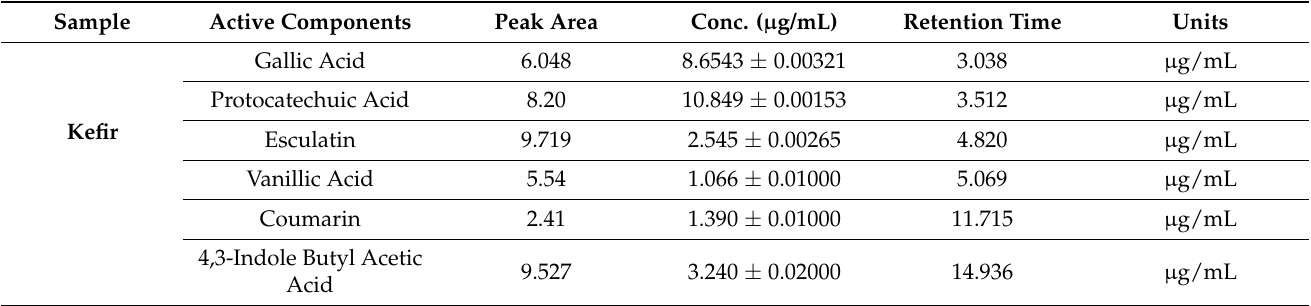
Figure 1. Detection of polyphenolic compounds of kefir by HPLC. Table 1. Polyphenol’s concentration of